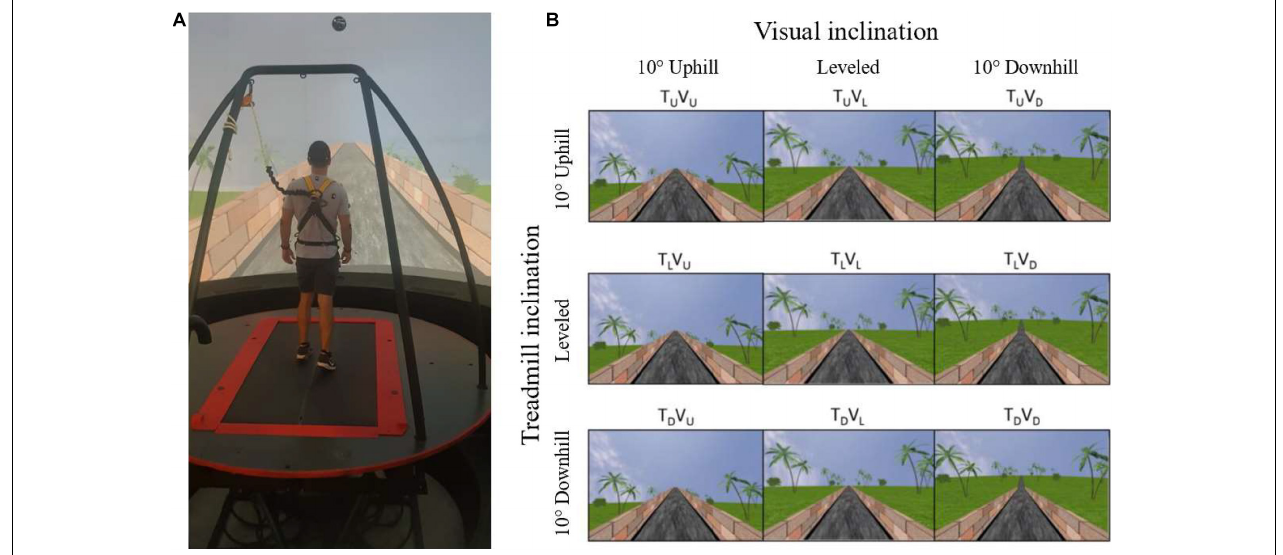
FIGURE 1 | Apparatus (A) and the main experimental conditions (B) . (A) A fully immersive virtual reality system containing an embedded treadmill synchronized with projected visual scenes, wherein in this example, the treadmill is leveled, and the vision is uphill [see T L V U in (B) ]. (B) Main experimental conditions. Following leveled walking and after reaching steady-state velocity (SSV) and maintaining it for 12 s, a transition (5 s) occurred to one of the 11 different conditions (see text for details) presented in random order, lasting 65 s, in which the inclination of the treadmill (T) and/or visual scenes (V) transitioned to 10 ◦ uphill ( U ), remained leveled ( L ) or transitioned to -10 ◦ downhill ( D ). Rows represent treadmill inclination changes, and columns represent visual scene inclination changes. Visual scene inclination effect was achieved by the road appearing above (uphill), below (downhill), or converging (leveled) with the line of the horizon. In addition, the peripheral greenery is exposed more (downhill) or less (uphill) by the road. Vision–treadmill congruent conditions appear on the diagonal (T L V L for continued leveled walking and T U V U and T D V D for uphill and downhill walking, respectively). Vision–treadmill incongruent conditions below the diagonal represent conditions with visual scene inclination more positive than the treadmill’s (T L V U , T D V U , T D V L ), and above the diagonal visual scene inclination more negative than the treadmill’s (T U V L , T U V D , T L V D ). See section “Materials and Methods” for more